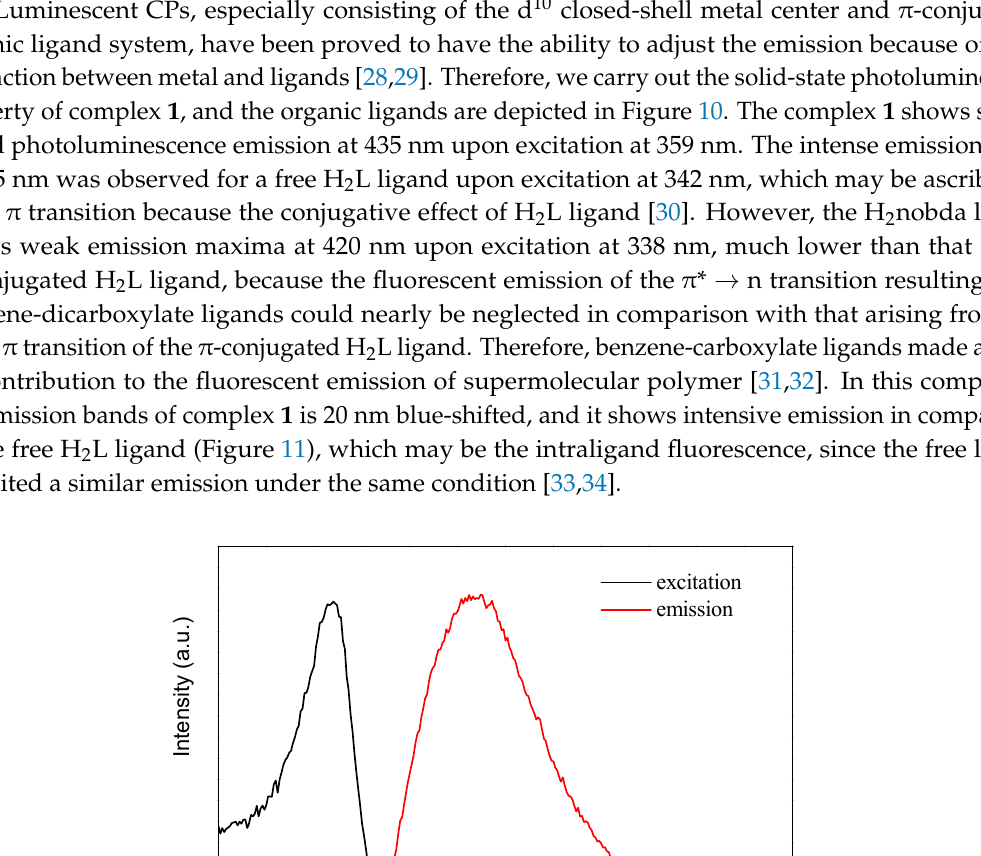
Figure 9. The band gap with 3.12 ev by the treatment with the Kubelka–Munk function.